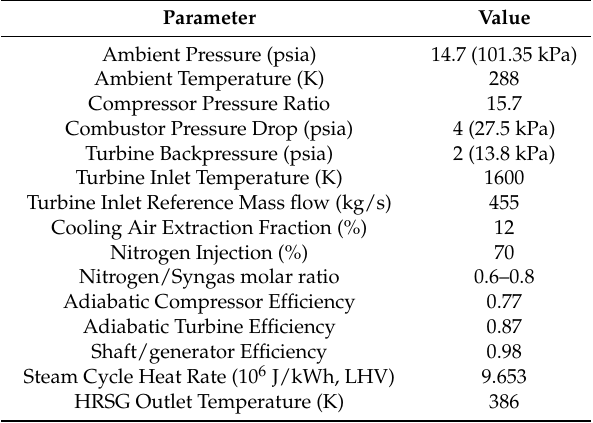
Table 4. Input assumptions for combined cycle system